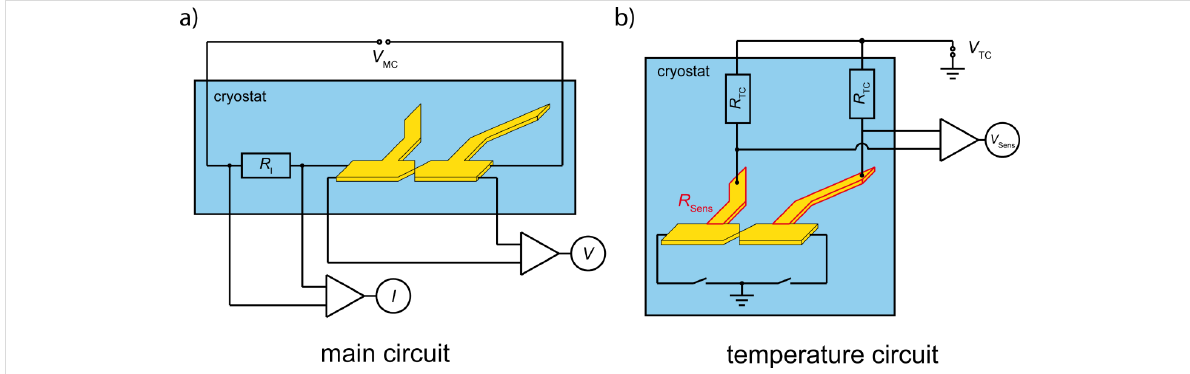
Figure 4: A schematic sketch of the measurement circuits. a) The main circuit where the current I is measured by the voltage drop across the pre- resistor R I = 812 Ω . b) The temperature circuit with R TC ≈ 5200 Ω and the sample connected to ground electrical potential.